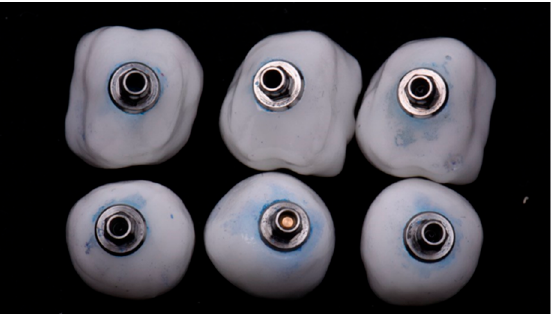
Figure 4. Hybrid abutment specimens after the dye exposure, thoroughly washed under running tap water for 5 min.